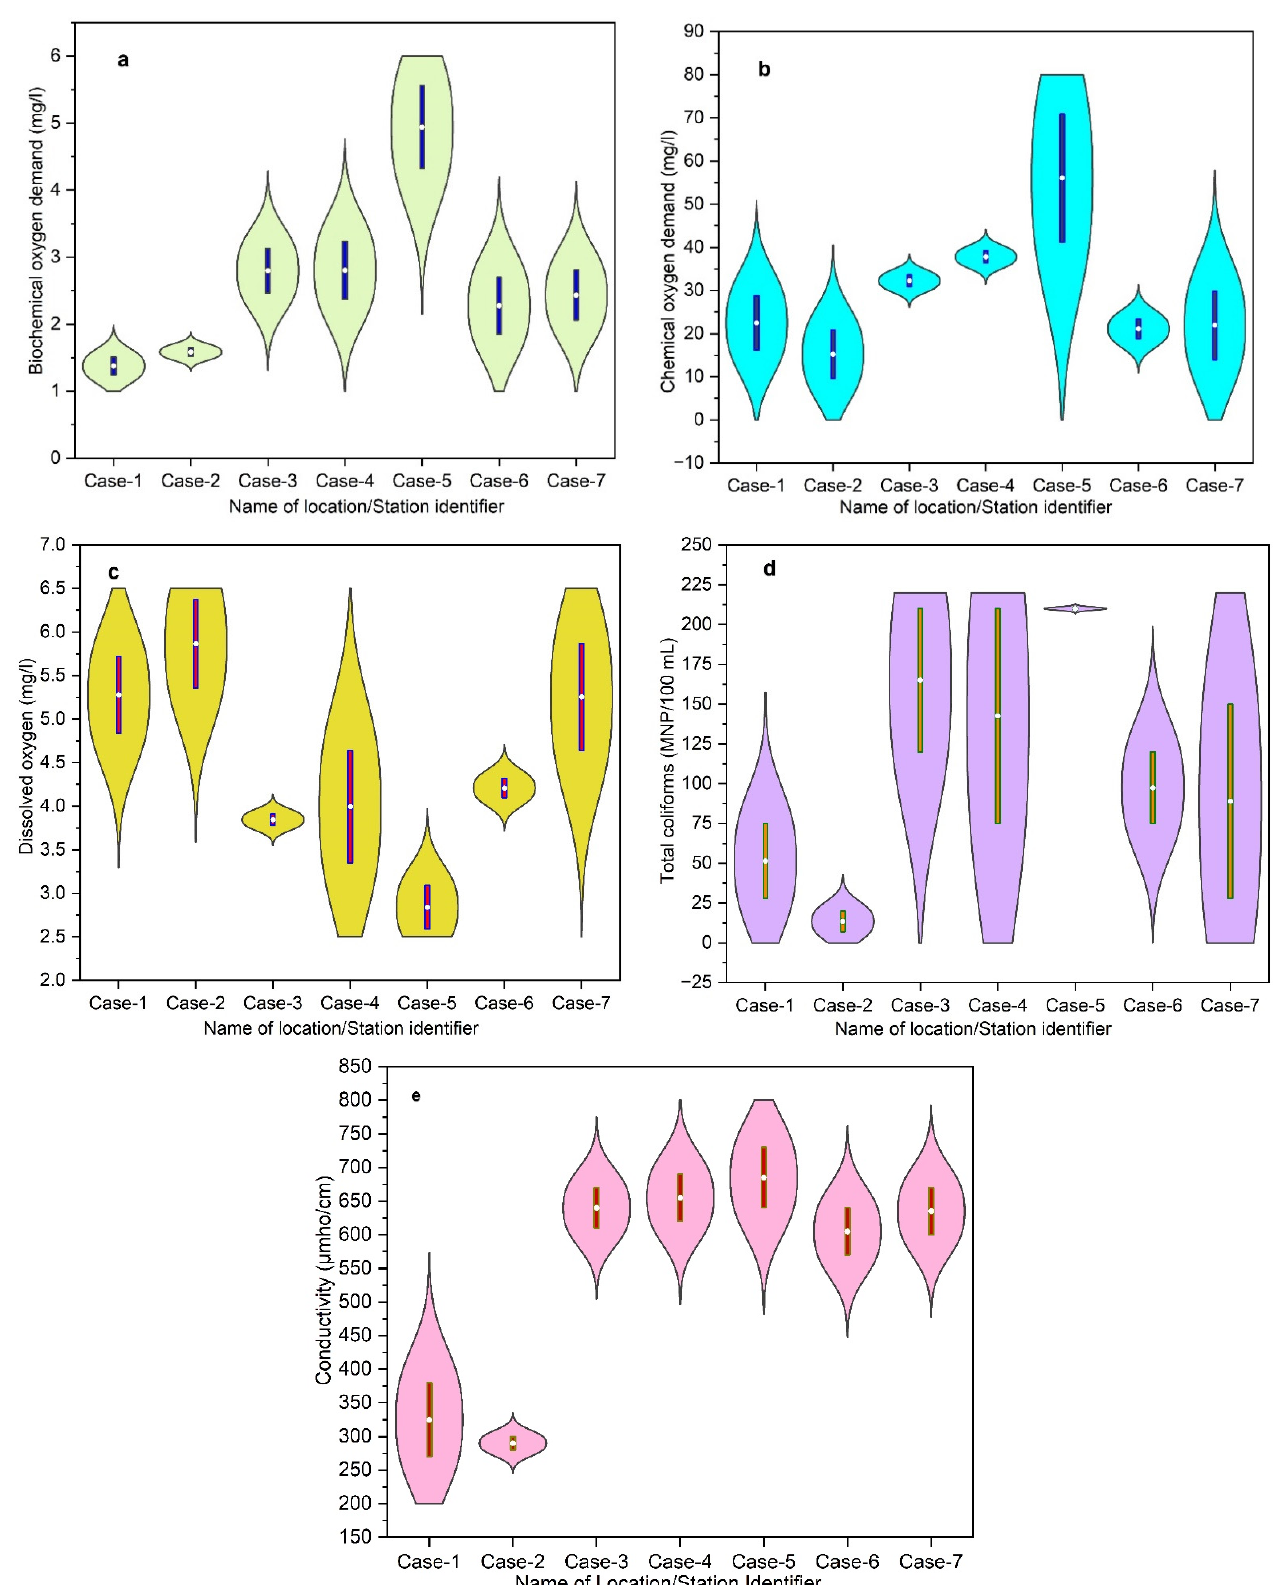
Figure 3. Violin graph for water quality monitoring stations of the Chambal River in Rajasthan: ( a ) biomedical oxygen demand, ( b ) chemical oxygen demand, ( c ) dissolved oxygen, ( d ) total coliforms, and ( e ) conductivity.